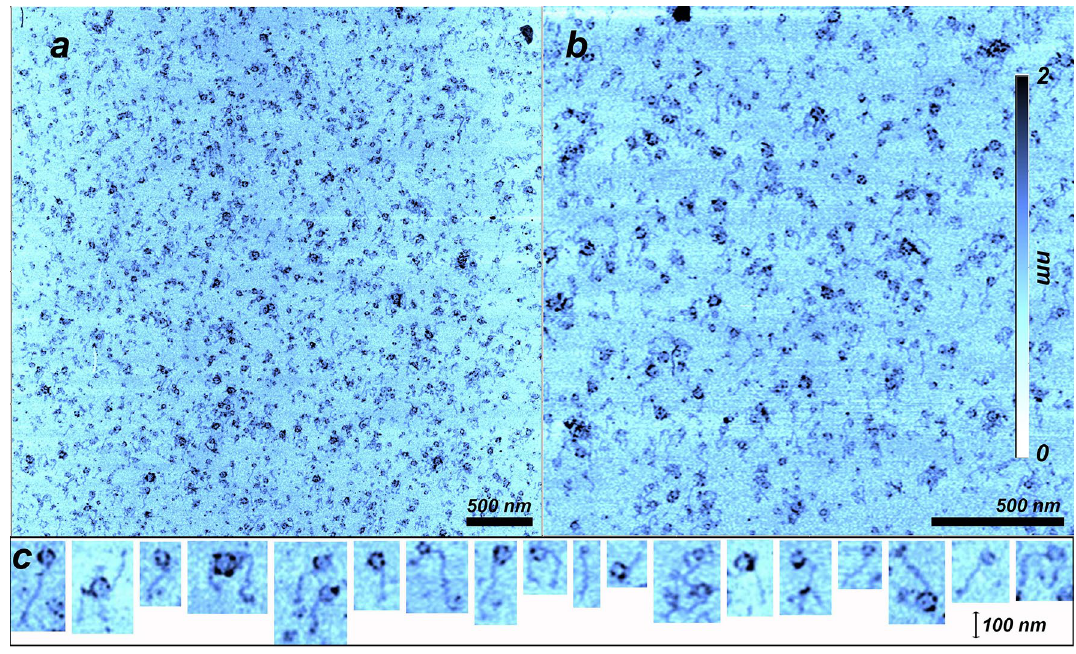
Figure 5. AFM images of rings produced by 80 °C wet-dry cycling of a 1:1 10 mM AMP + UMP solution on a mica surface from two different spots on the same surface. ( a ) 4 µm × 4 µm, ( b ) 2 µm × 2 µm. The color scale covers the range from 0 to 2 nm for all the images. ( c ) Zoom in on structures from ( a ) and ( b ) showing various examples of rings with associated or attached